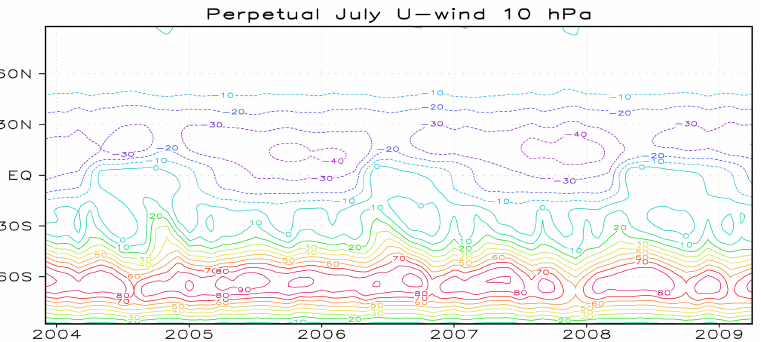
Figure 4. Time–latitude cross-section of zonal–mean-zonal wind (ms − 1 ) at 10 hPa in the upper stratosphere for the perpetual July run. Contours interval is 10 ms − 1 .